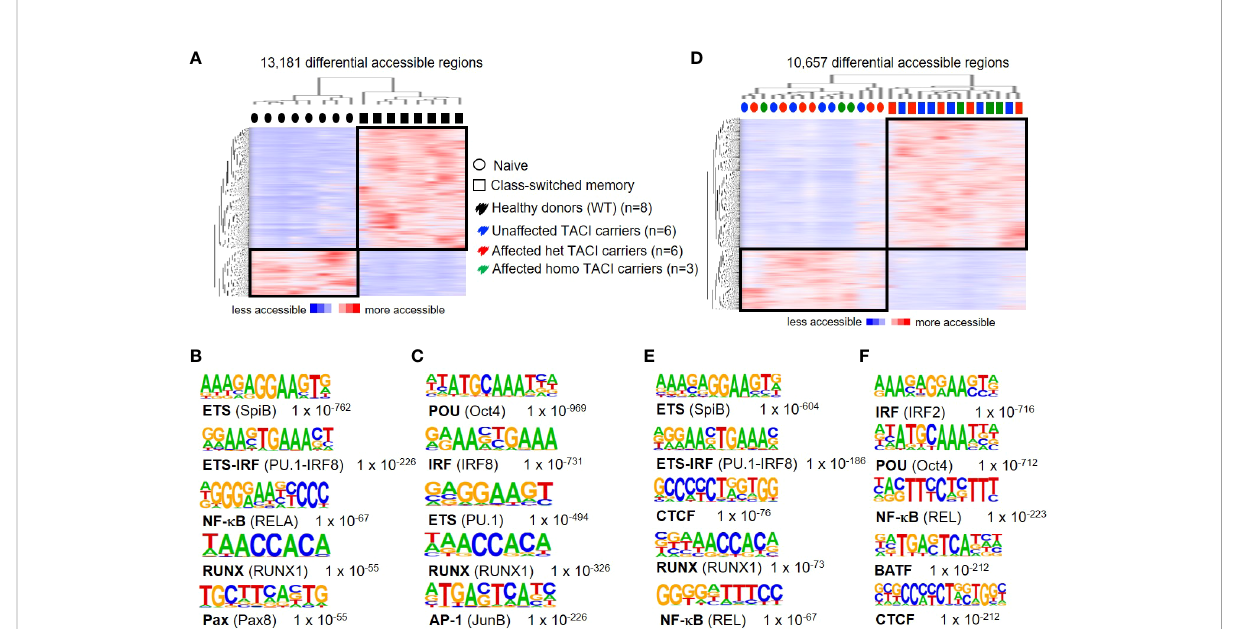
FIGURE 1 Chromatin accessibility landscapes from unstimulated naïve and CSM B cells from TACI mutation carriers and healthy donors. (A) Heatmap from healthy donors including hierarchical clustering of 13,181 differentially accessible chromatin regions in naïve B cells compared to CSM B cells. Preferentially open regions amounted to 3,736 in naïve B cells and 9,445 in CSM B cells. (B, C) Cis-regulatory sequences associated with regions of the (B) naïve B cells or (C) CSM B cells. (D) Heatmap from TACI mutation carriers including hierarchical clustering of 10,657 differentially accessible chromatin regions in naïve B cells compared to CSM B cells. Preferentially open regions amounted to 3,467 in naïve B cells and 7,190 in CSM B cells. (E, F) Cis-regulatory sequences associated with the regions of the (E) naïve B cells or (F) CSM B cells. Transcription factor family stated fi rst and in brackets the family member. Genes were normalized and centered with Cluster 3.0 and visualized with Java Treeview with color indicating the region with maximum (red) or minimum (blue) open chromatin. Sequence logos and p -values re fl ecting the signi fi cance of motif occurrence are shown next to the corresponding